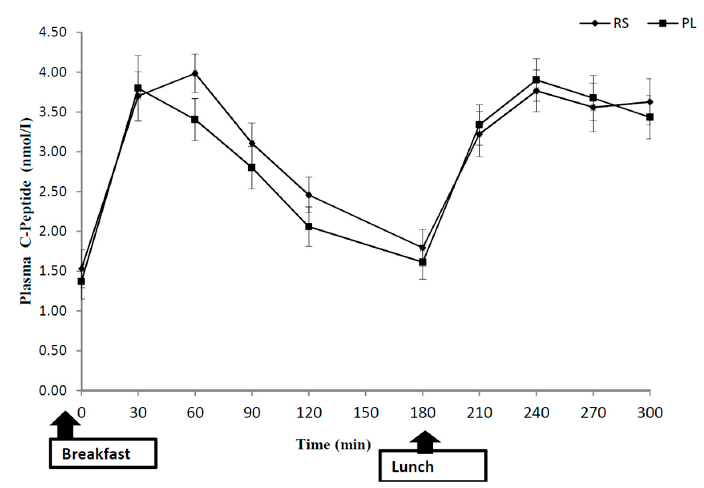
Figure 2. Postprandial plasma glucose concentrations after the consumption of 48 g of resistant starch (RS) compared with a placebo (PL). The values represent means ± SEM ( n = 10). Comparisons were made with repeated measures ANOVA.